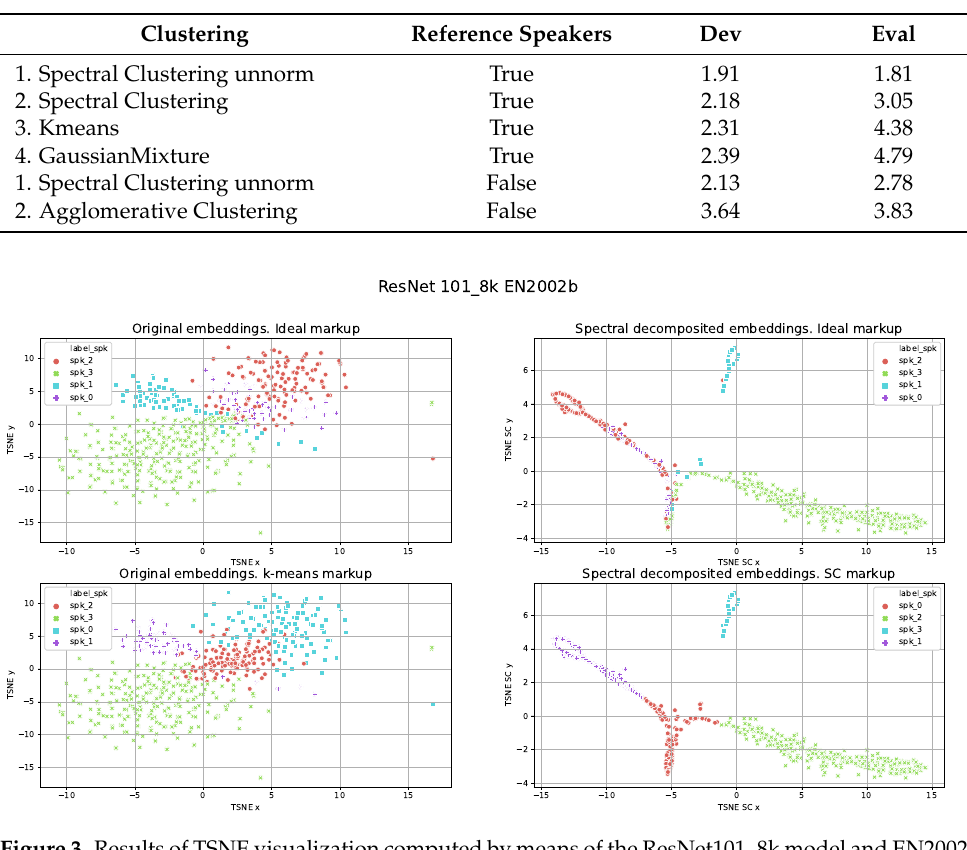
Figure 3. Results of TSNE visualization computed by means of the ResNet101_8k model and EN2002b lapel-mix file from the AMI evaluation dataset. All overlapping speech segments were removedto reduce uncertainty. In the left parts of the images, the original speaker embeddings are used; in the right parts the speaker embeddings after spectral decomposition are